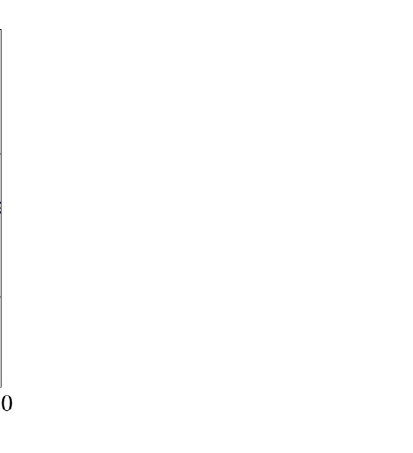
Figure 13. Comparison of global z-direction velocity histories of the blocks calculated by SPH and FEM.